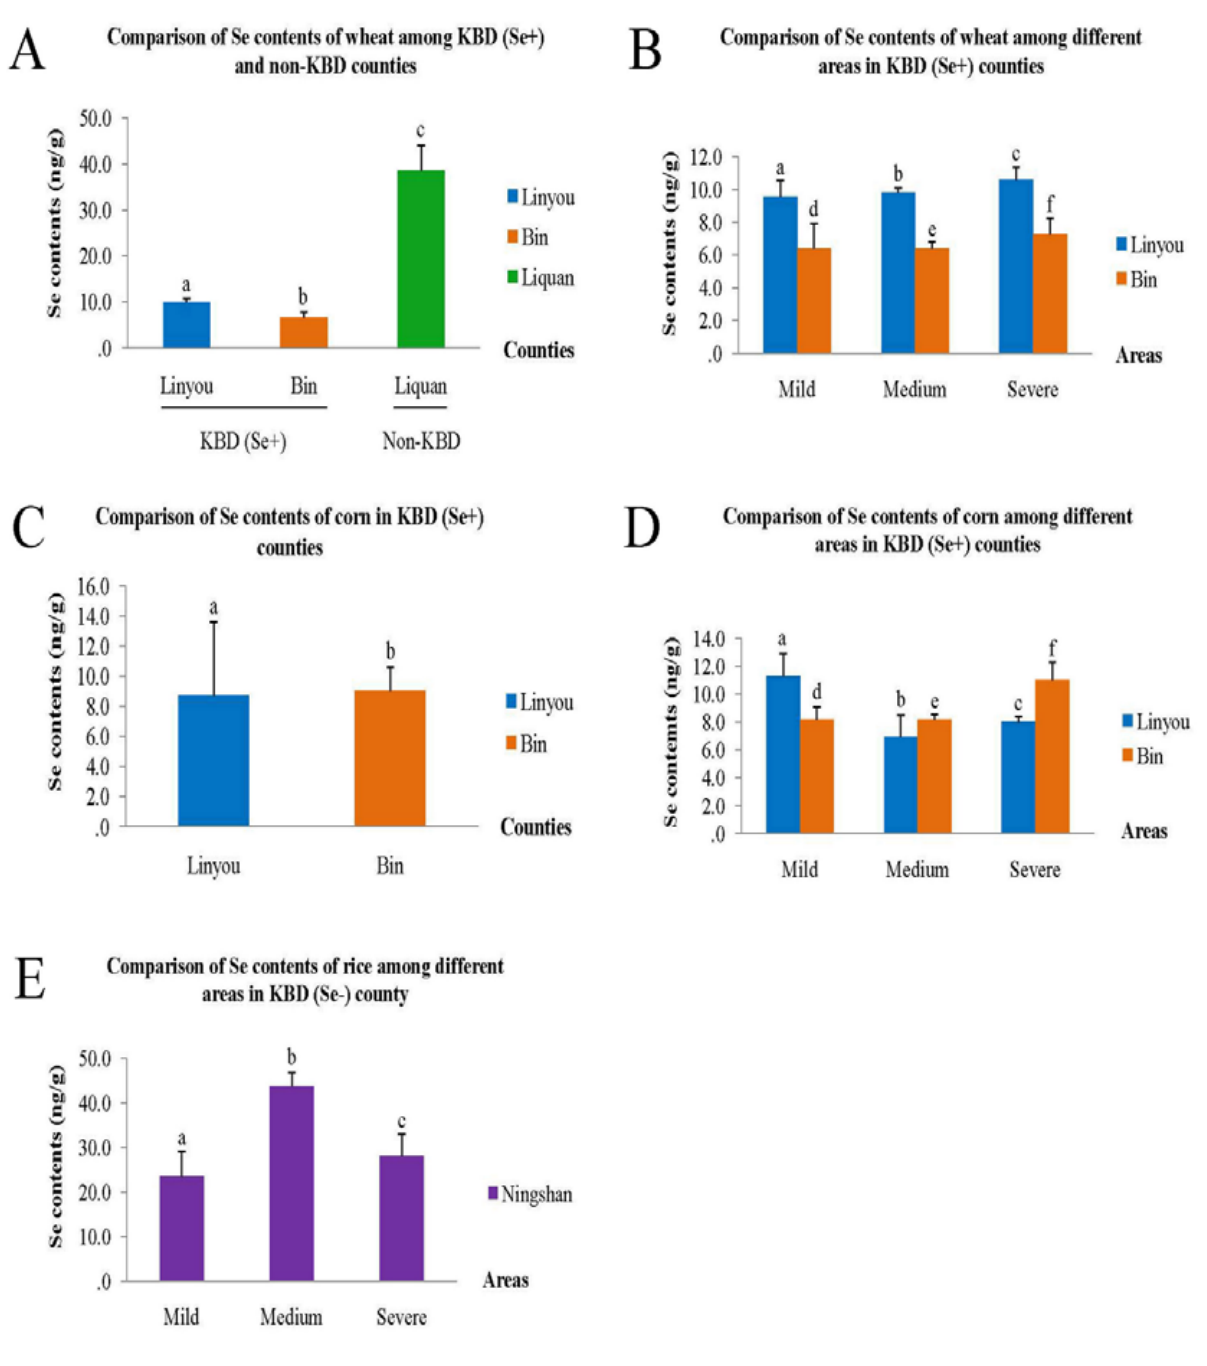
Figure 4. Comparisons of Se content of food samples. If the letters above the bars are different that means the difference between or among groups was significant, otherwise it means the difference was insignificant. Table 3. Significant influence factors of hair Se content of children identified by univariate and multivariate regression analyses.